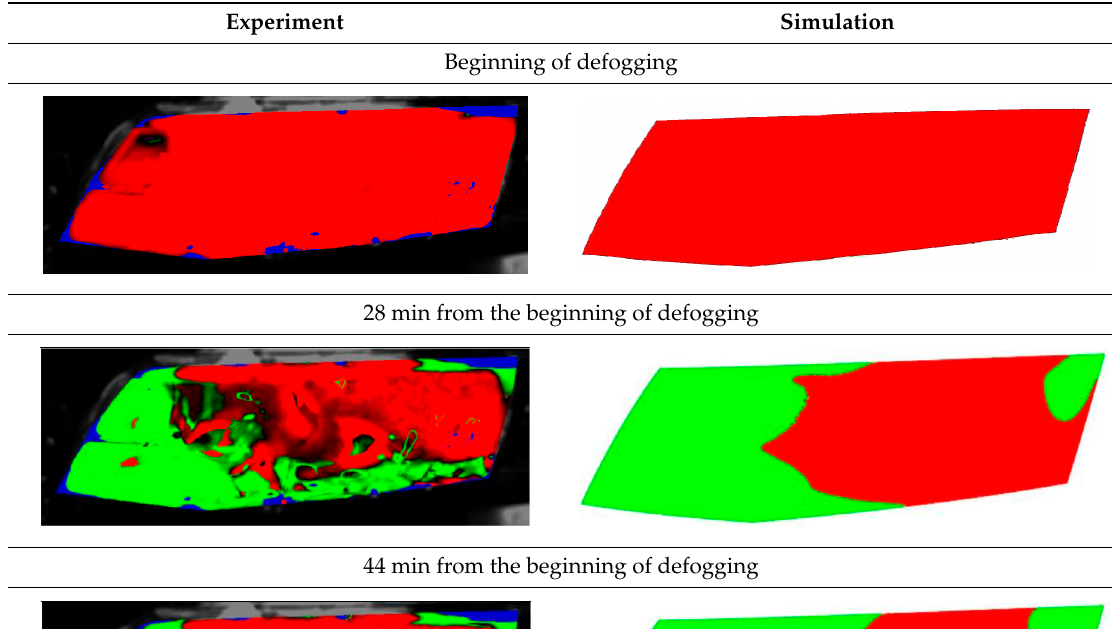
Table 9. Visual comparison of C1.5 results (red—fogged, green—defogged,